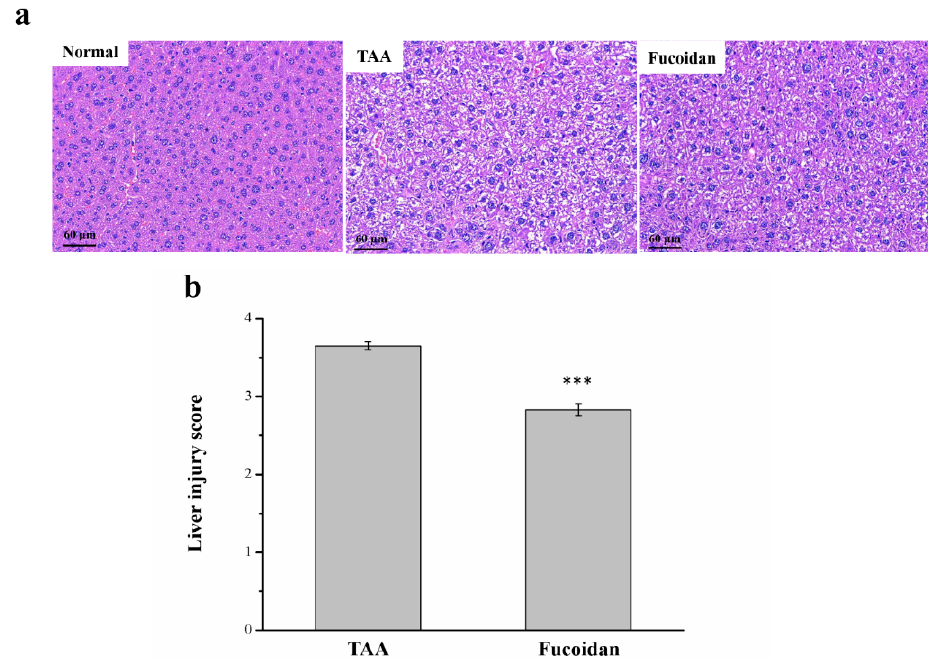
Figure 4. Changes of the ( a ) liver histology by hematoxylin and eosin (H&E) staining (magnification 200 × ), and ( b ) the scoring index of liver injuries in normal mice, mice with TAA-induced liver injury, and fucoidan-treated mice with TAA-induced liver injury over a period of 42 days. All data are presented as the means ± SEMs ( n = 10). Statistical significance at *** p < 0.001.